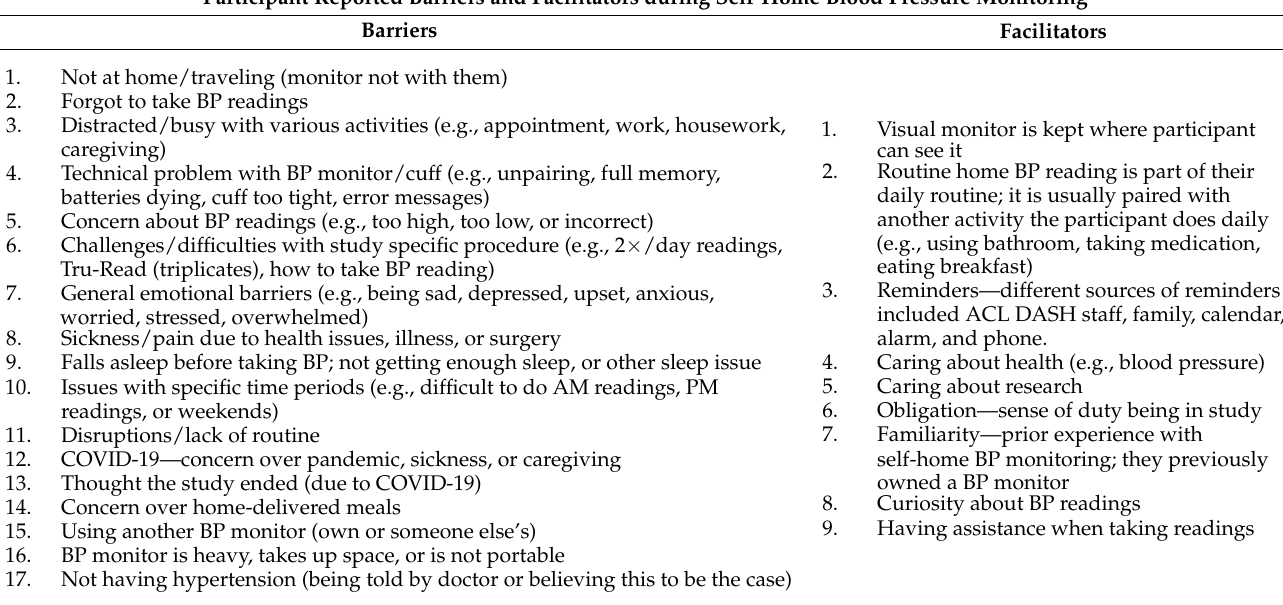
Table 5. Barriers and facilitators to self-home blood pressure